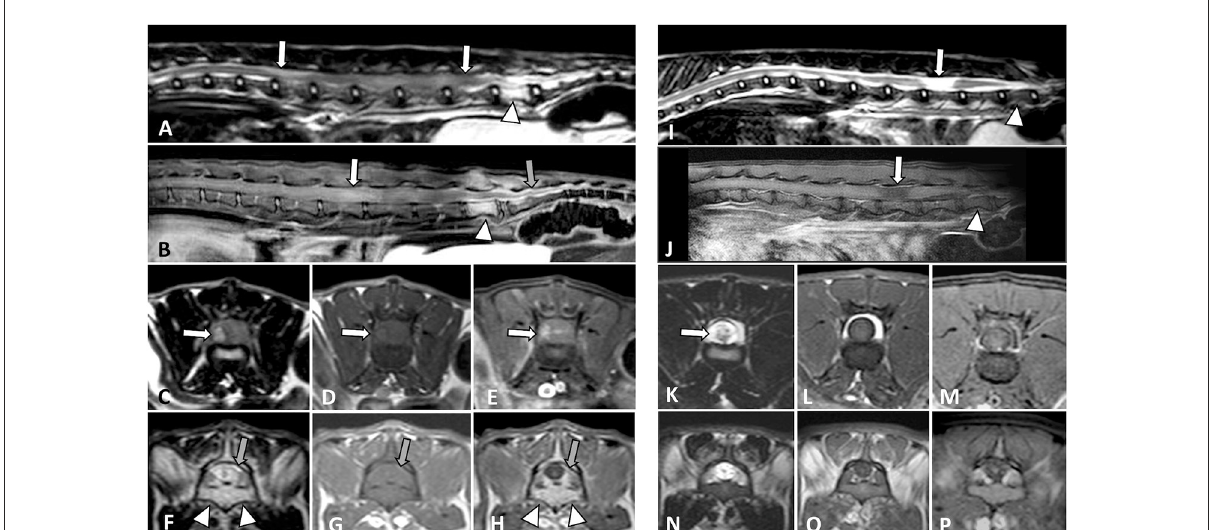
FIGURE1 MRI studies of a 1-year-old domestic short-haired paraplegic cat. A multifocal large cell lymphoma with an intramedullary lumbosacral lesion and a sacrococcygeal epidural lesion was diagnosed. On T2W sagittal plane (A) the spinal cord is swollen with an increased heterogeneous signal from L2 to L6 vertebrae (arrows). On T1W post-contrast SPIR sagittal plane (B) there is a diffuse intramedullary contrast enhancement (white arrow) and an intense epidural enhancement from L7 to the first coccygeal vertebrae (gray arrow). On transverse planes at the level of L4-L5 vertebrae, the spinal cord appears swollen due to an intramedullary lesion with a right component which is hyperintense on T2W (C) , isointense on T1W (D) , and shows heterogeneous enhancement on post-contrast SPIR (E) images. On transverse planes at the level of the L7 vertebra, there is an epidural infiltrative lesion hyperintense on T2W and isointense on T1W images (gray arrows in F,G , respectively) with intense post-contrast enhancement (gray arrow in H ). An increased signal of the L7 bone marrow with cortical sparing is observed (arrowheads in A,B,F,H ). After chemotherapy and clinical improvement, an MRI was performed at 3 months (I–P) . On the sagittal planes ( I , T2W; J , T1W post-contrast SPIR) the L7 bone marrow signal was normalized (arrowheads) and a malacic lesion, presumptively residual, was present along the L5 vertebra (arrows). On transverse planes at the level of L4-L5 vertebrae ( K , T2W; L , T1W and M , T1W post-contrast SPIR), the previous intramedullary lesion was not observed, and signs of malacia were seen (arrow in K ). The corresponding L7 vertebra transverse planes (N–P) did not show epidural